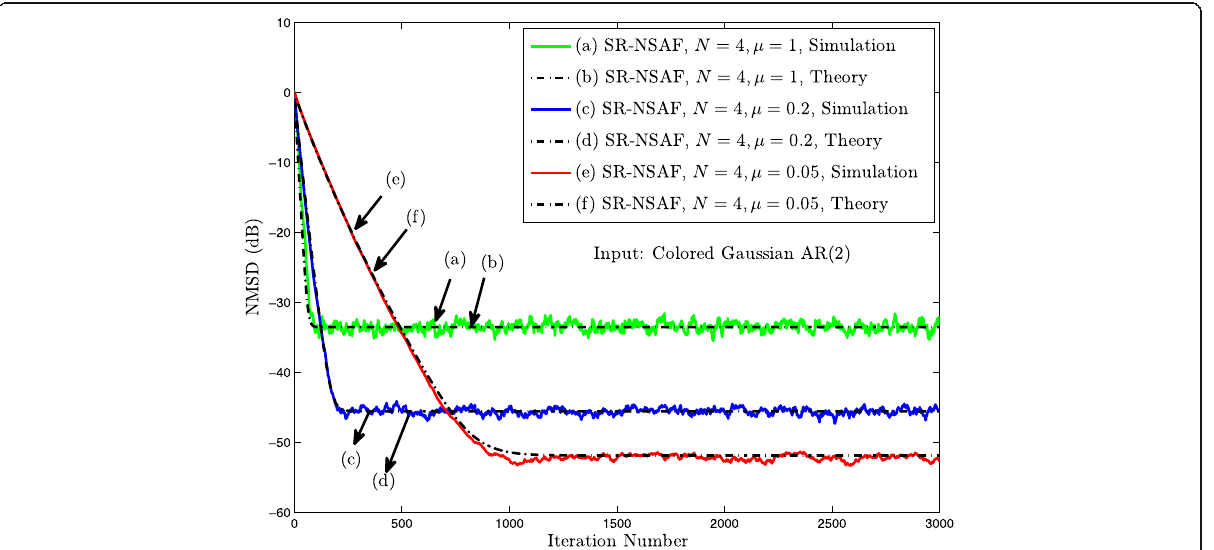
Fig. 22 Simulated and theoretical NMSD learning curves of SR-NSAF for different values of μ